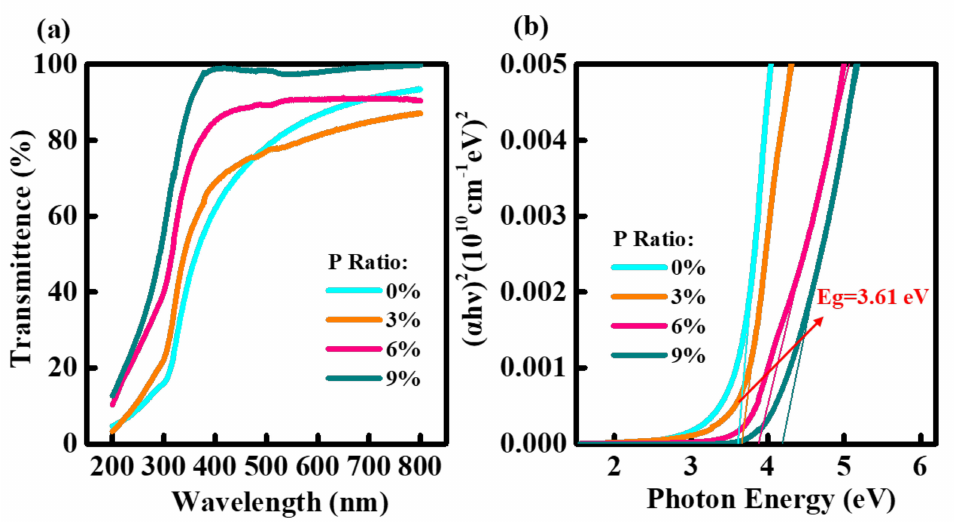
Figure 3. ( a ) Optical transmittance spectra of IPO films with various P ratios, and ( b ) corresponding optical bandgaps derived from the Tauc plots.